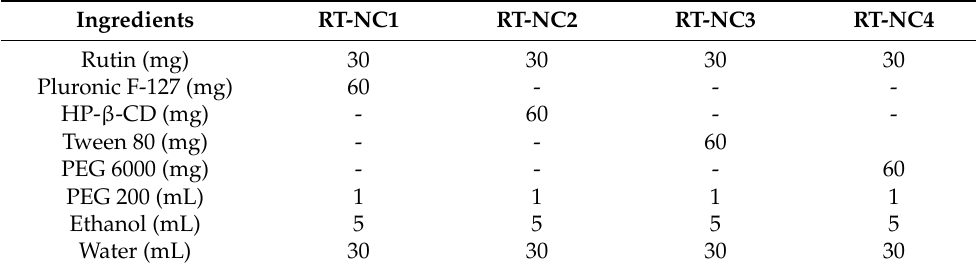
Table 1. Composition of RT-NCs prepared using different stabilizers at a weight ratio of 2:1, w / w (drug: